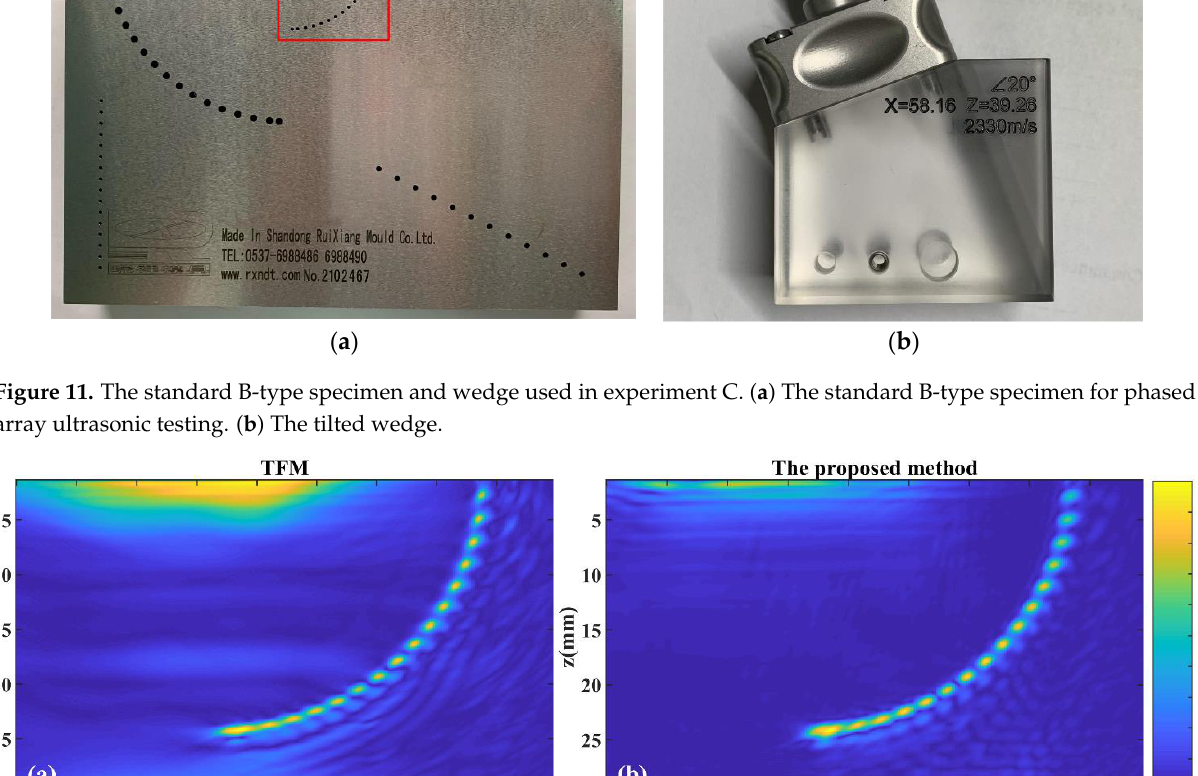
( b ) Figure 10. The experimental results for the SDHs in a two-layer structure. ( a ) The image reconstructed by the proposed method. ( b ) The normalized amplitudes of four SDHs. Table 5. FWHMs and time costs of the proposed method in experiment B. Items